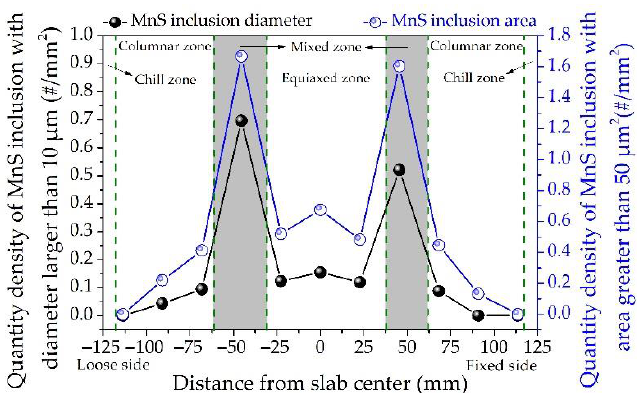
Figure 5. Distribution of large-size MnS inclusions along the slab thickness of medium carbon structural steel 45#.